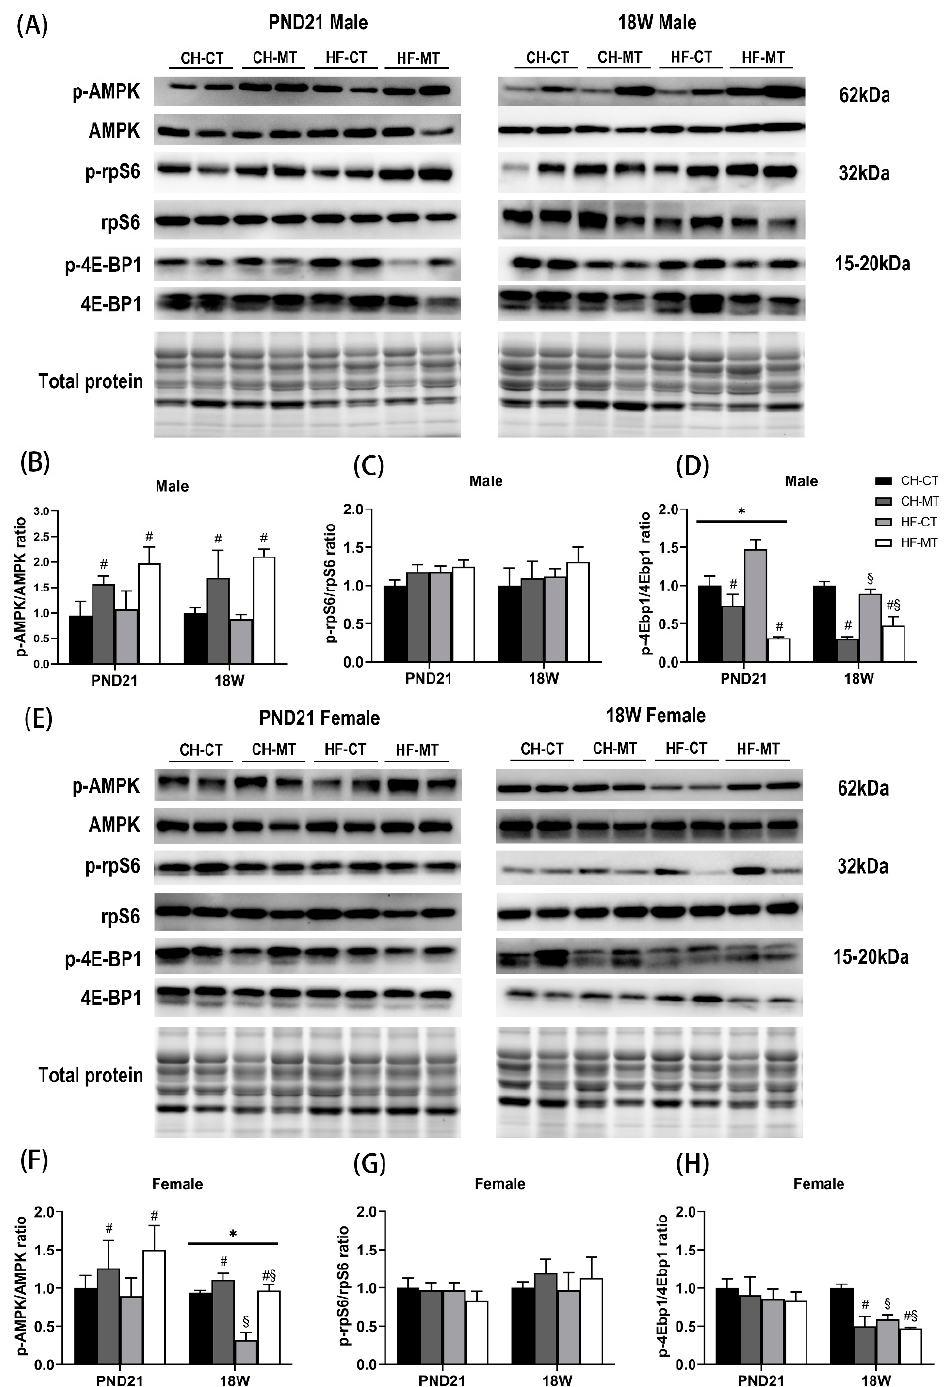
Figure 6. Expression of total and phosphorylated AMP-activated protein kinase (AMPK), ribosomal protein S6 (rpS6) and eukaryotic initiation factor 4E-binding protein 1 (4E-BP1) in skeletal muscle of offspring. ( A ) Representative Western blots of total and phosphorylated AMPK, rpS6 and 4E-BP1 in skeletal muscle of PND21 and 18W male offspring. Histograms summarized phosphorylated-to-total ratio of AMPK ( B ), rpS6 ( C ) and 4E-BP1 ( D ) in male offspring. ( E )